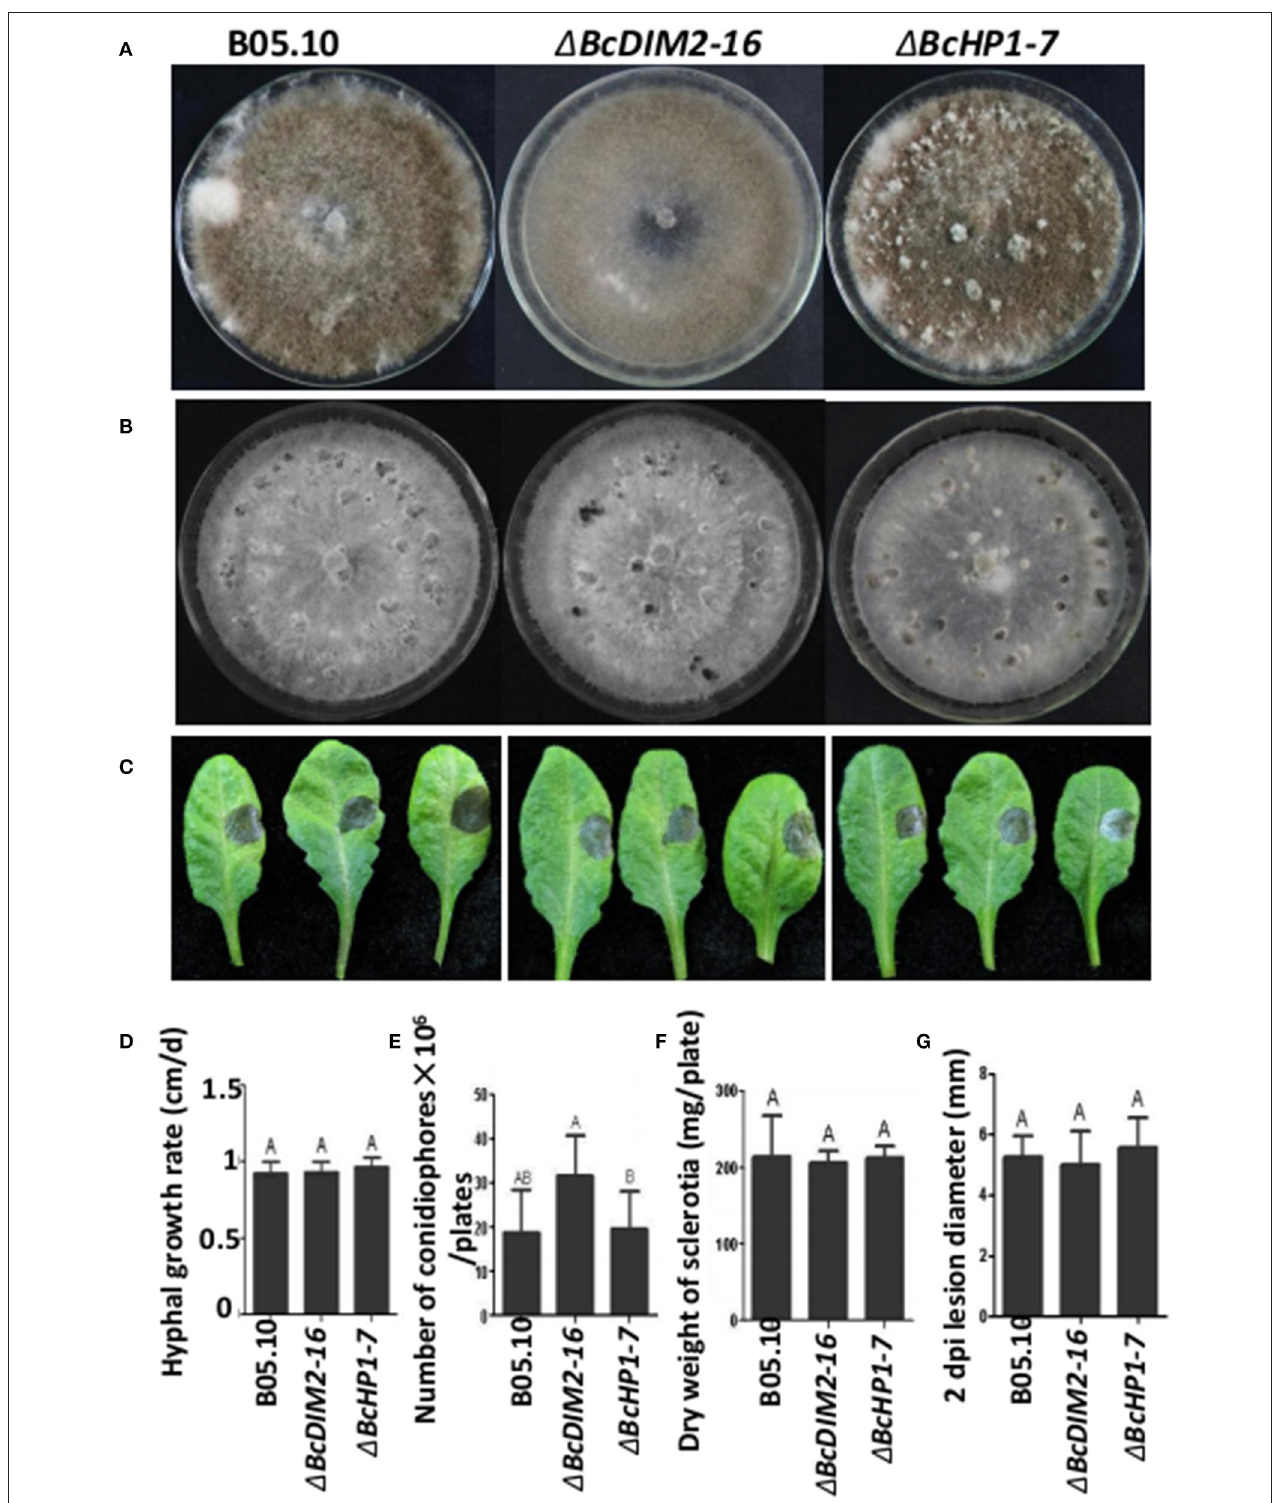
FIGURE 6 | Phenotypes of BcDIM2 and BcHP1 knockout transformants. (A) Comparison of the phenotypes of the ∆ BcDIM2-16 and ∆ BcHP1-7 knockout transformants. All the strains were grown on a PDA plate at 20 ◦ C for 15 days under a 12h light/12h dark photoperiod. (B) Comparison of the phenotypes of